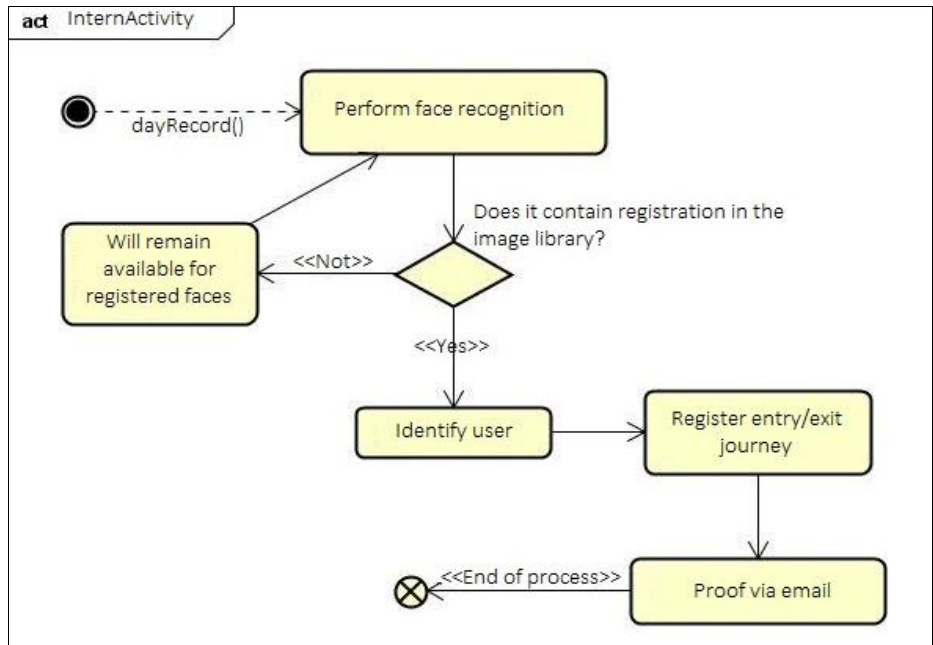
Figure 3: Intern's clocking time register